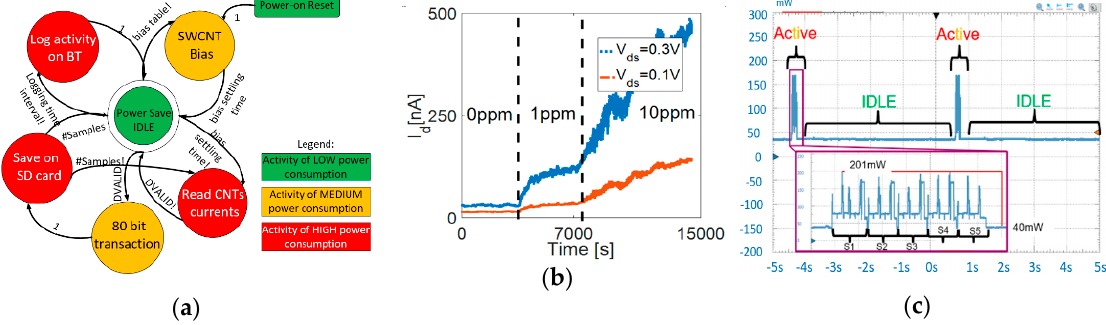
Figure 2. ( a ) Finite-state machine (FSM) states, transitions and power level; ( b ) CNT sensor response at various NO 2 levels, V gs = − 5V; ( c ) platform power consumption in Active and IDLE